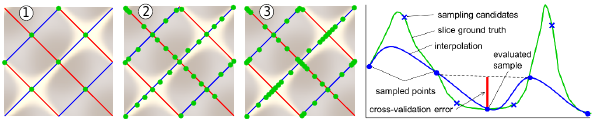
Fig. 4 Individual steps of the adaptive sampling algorithm, and the cross-validation procedure